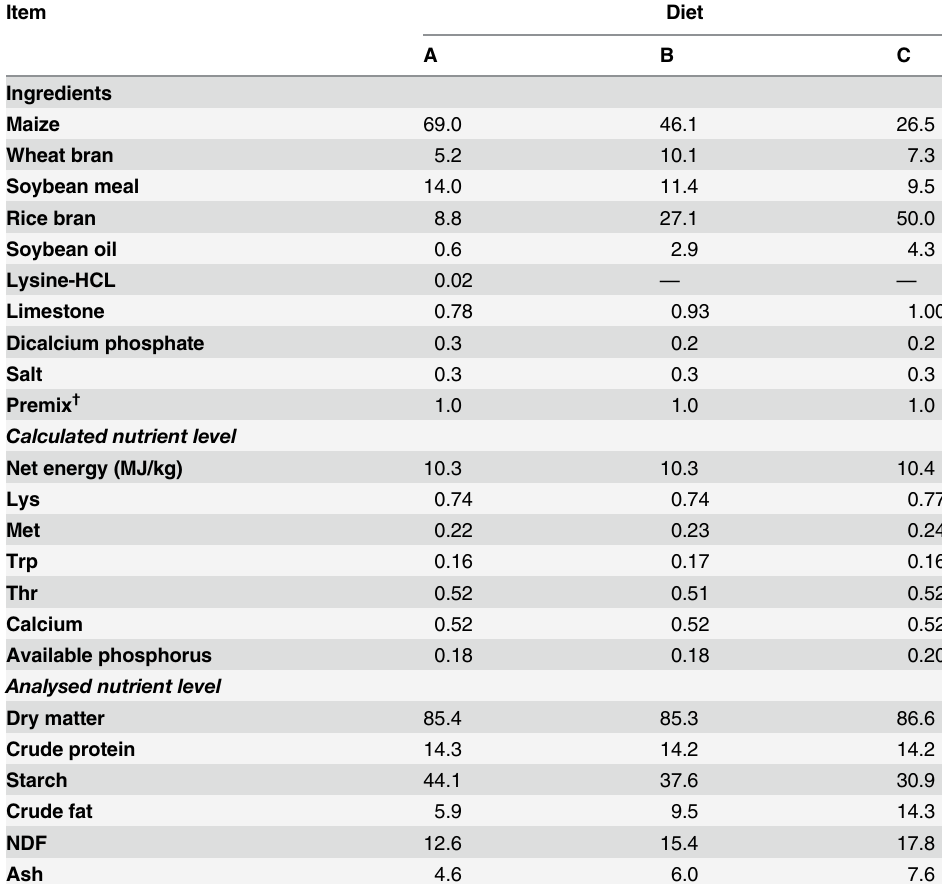
† The premix provided per kilogram of diet: 100 mg of iron as iron sulphate, 100 mg of zinc as zinc oxide, 30 mg of manganese as manganous oxide, 20 mg of copper as copper sulphate, 0.3 mg of selenium